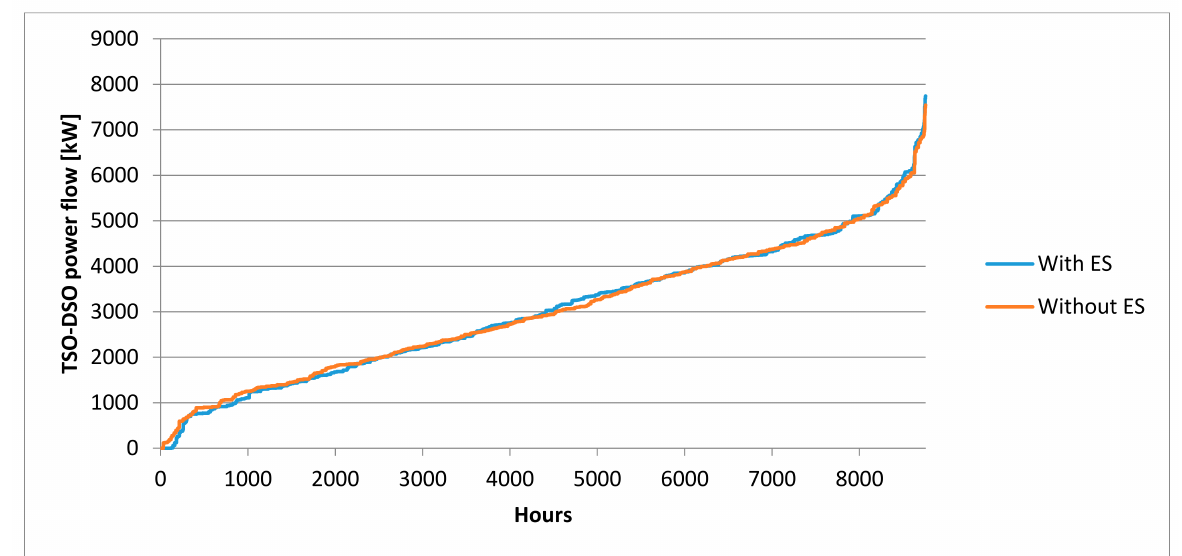
Figure A5. TSO-DSO power flow with and without ES for 40% energy from RES.